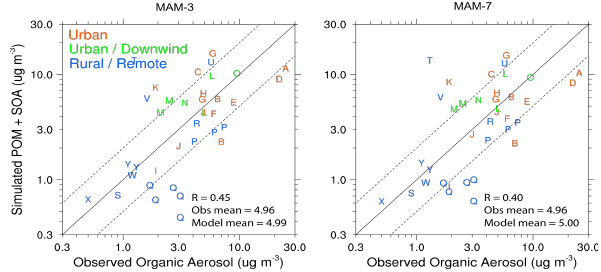
Fig. 14. Observed and simulated organic aerosol concentrations at various locations and times as reported and compiled by Zhang et al. (2007). Simulated values for MAM3 (left) and MAM7 (right) are from model lowest layer except for Jungfraujoch site (symbol W).